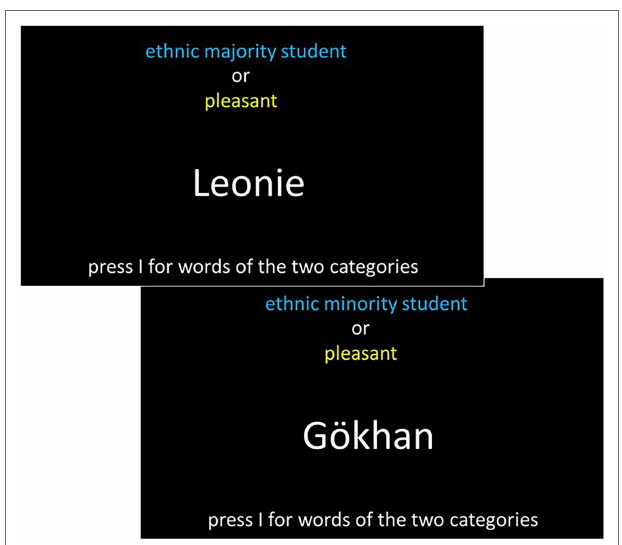
FIGURE 3 | Schematic presentation of the